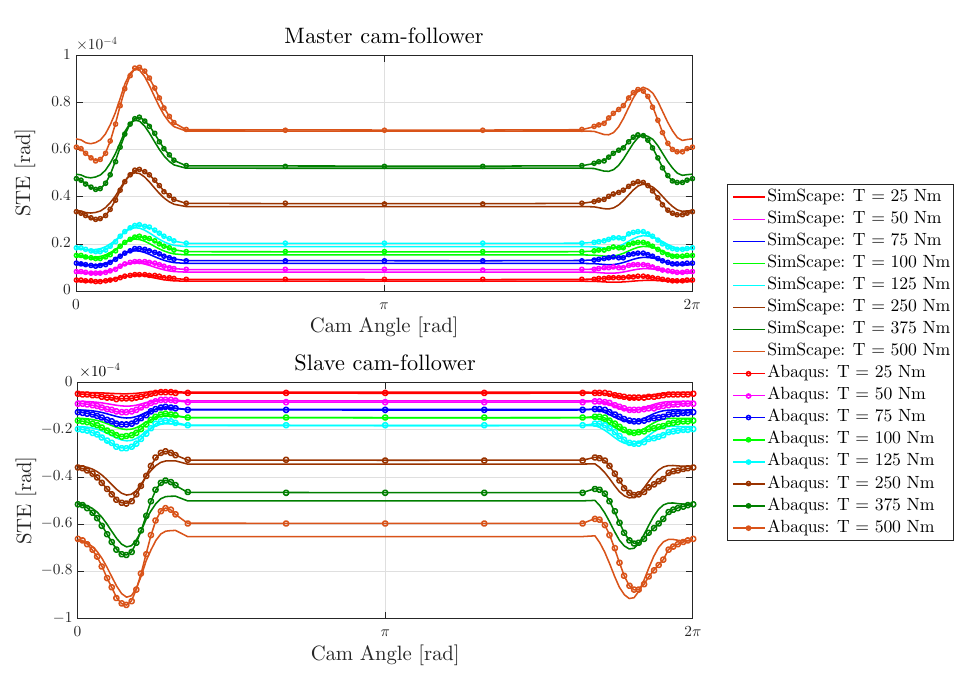
Figure 6. STE comparison of the Simscape LPM and FEM for both master ( top ) and slave ( bottom ) cam-follower subsystems at different torque levels.